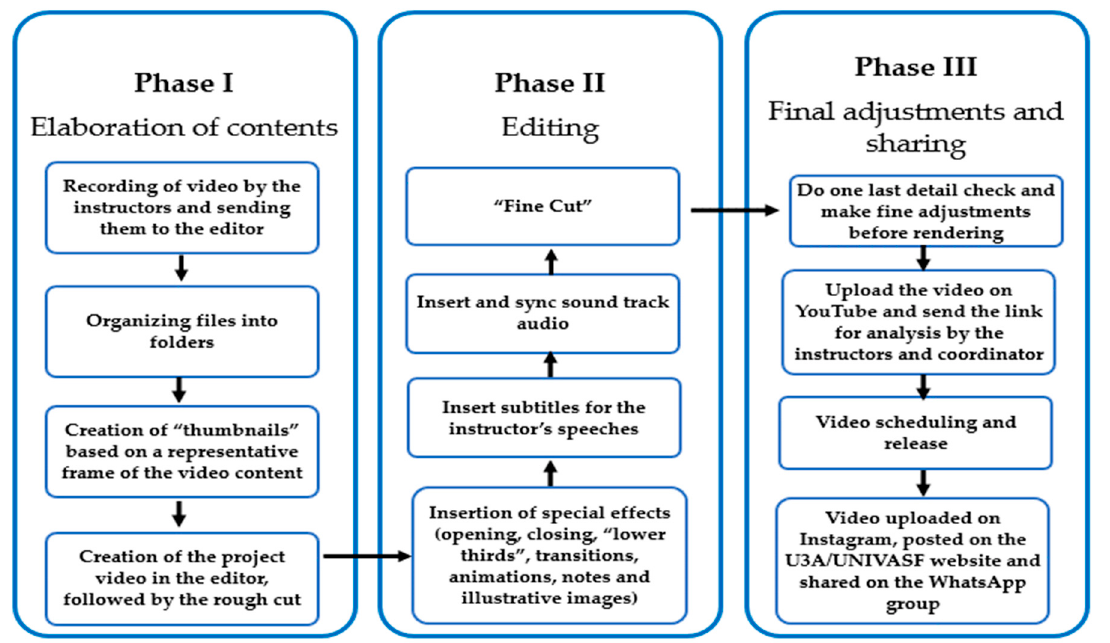
Figure 1. Flowchart of video recording and editing procedures for the “U3A in Motion” program (2020–2021).